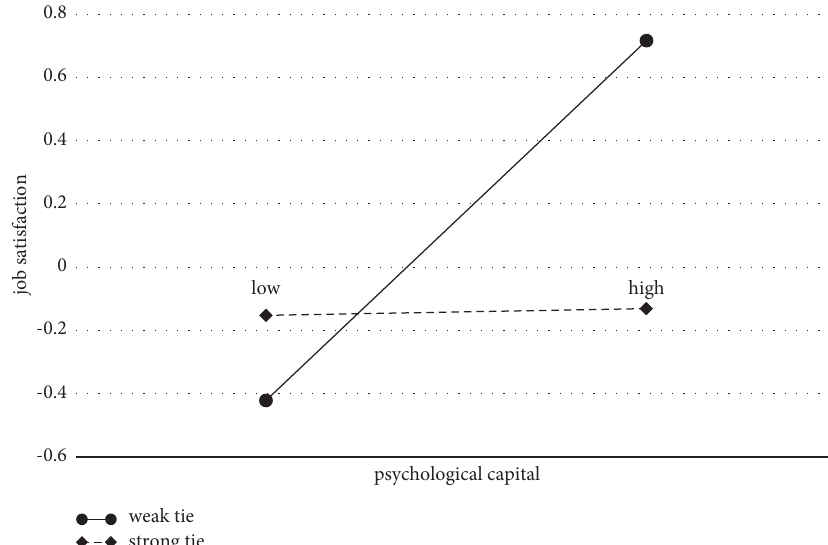
Figure 4: Interaction of psychological capital and tie strength on job